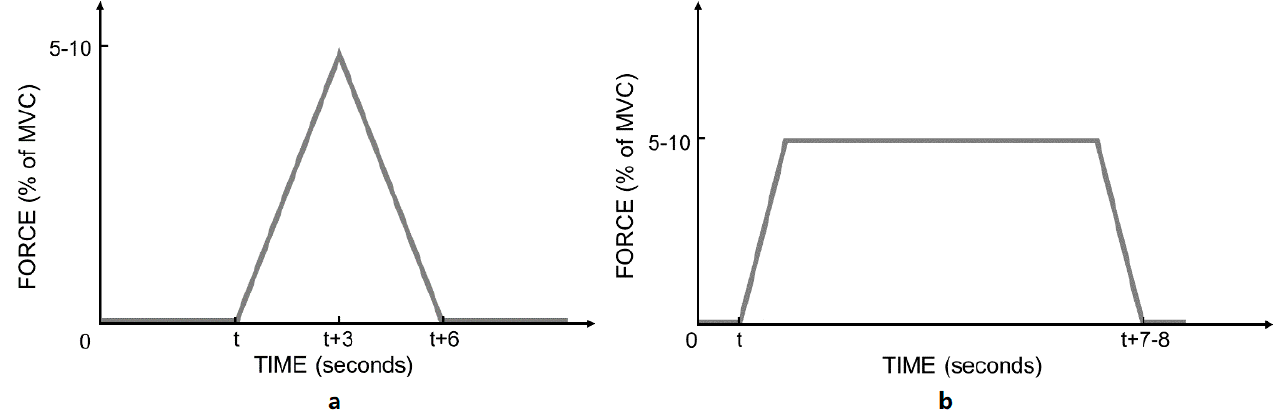
Figure 2. Force pattern for the subject to follow. ( a ) “Ramp” condition; ( b ) “ramp and maintain” condition.